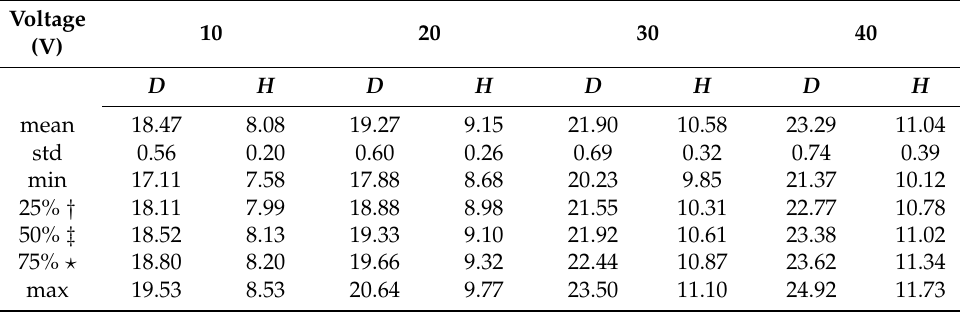
Table 4. Diameter and depth of machined cavities with different applied